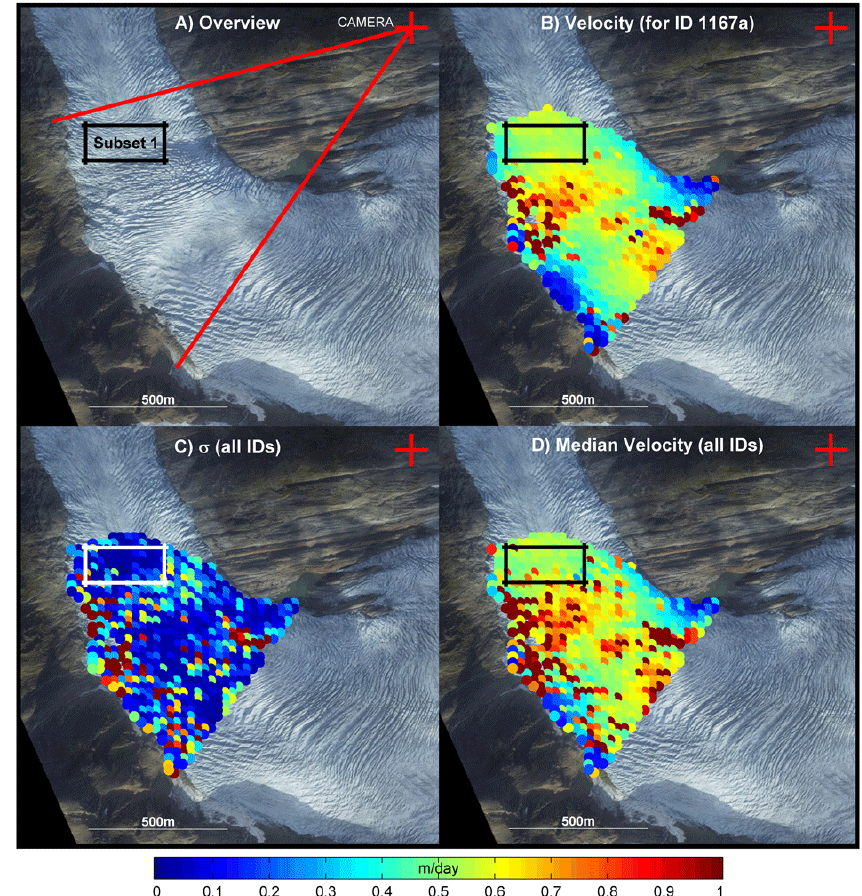
Figure 6. (a) Time-lapse location on the valley side; red lines indicate the viewshed. Subset 1 is the test area used to derive the median displacements presented in Table 2. (b) Example of the raw velocity field produced as output from the ImGRAFT toolbox. (c) Standard deviation plot of velocity fields produced from all the image pairs in Table 2. (d) Median velocity plot for all the image pairs presented in Table 2. Note that we use the median over the mean as it is robust to